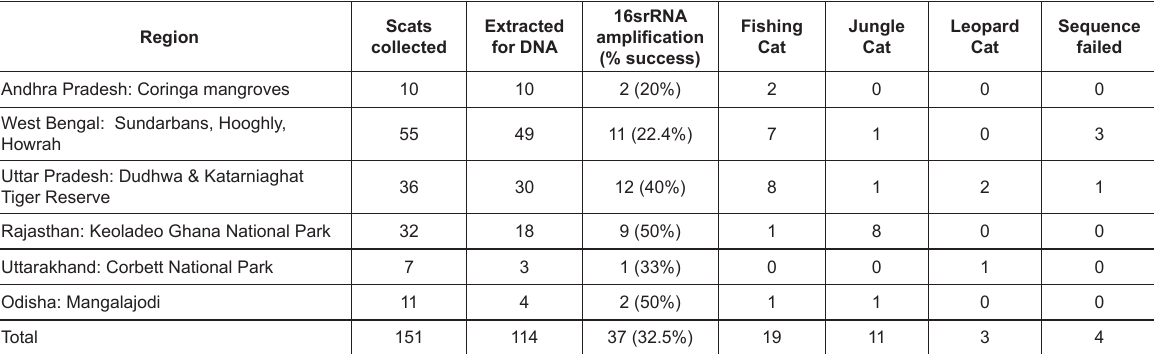
Table 1. Summary of results of scat collection and identification Region